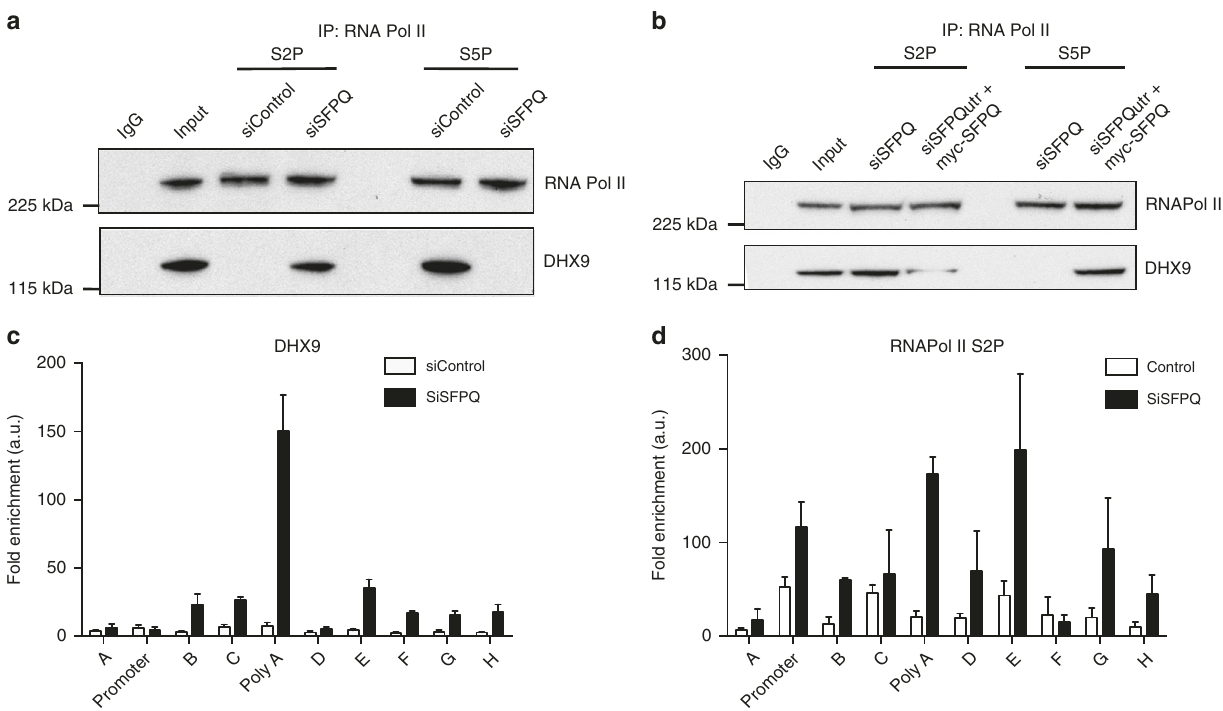
Fig. 8 DHX9 associates with different phosphorylated forms of RNA Polymerase II. a Western blot of RNA Pol II and DHX9 immunoprecipitated from HeLa cells with antibodies speci fi c for phosphor-serine 2 (S2P) and phosphor-serine 5 (S5P) forms of RNA Pol II. Where indicated cells were transfected with siRNA against a scrambled DNA sequence (siControl) or against SFPQ (siSFPQ8, siSFPQ9). b Expression of siRNA-resistant myc-SFPQ in SFPQ knockdown cells promotes the association of DHX9 with RNA Pol II S5P and diminishes its association with S2P. c Chromatin immunoprecipitation of DHX9 at the Β -actin locus. Data are depicted as fold enrichment over the control IP. qPCR of IP samples was performed for the primer pairs described in Fig. 6a. Means and s.e.m. are plotted and data are an average from three independent replicates. d Chromatin immunoprecipitation of RNA Pol II S2P at the Β -actin locus as described in